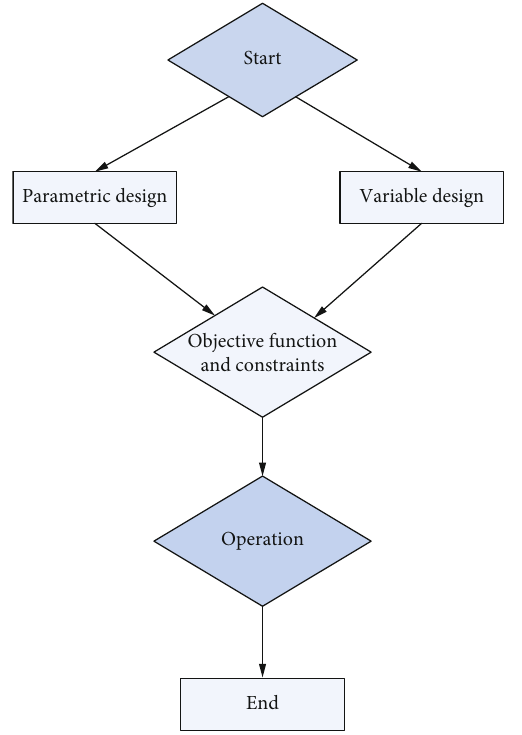
Figure 3: Intelligent network mapping algorithm fl